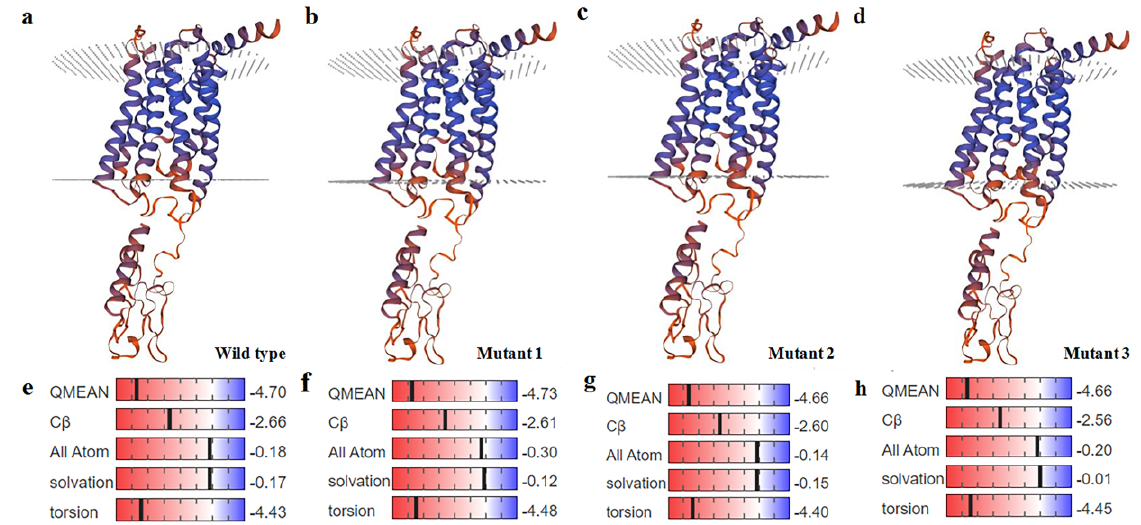
Figure 6. The predicted 3D structureand QMEAN of the bovine GHRHR gene. ( a , e ), wild-type; ( b , f ), the mutant 1-type of Gln to Pro; ( c , g ), the mutant 2-type of His to Pro; and ( d , h ), the mutant 3-type of both Gln and His to Pro.